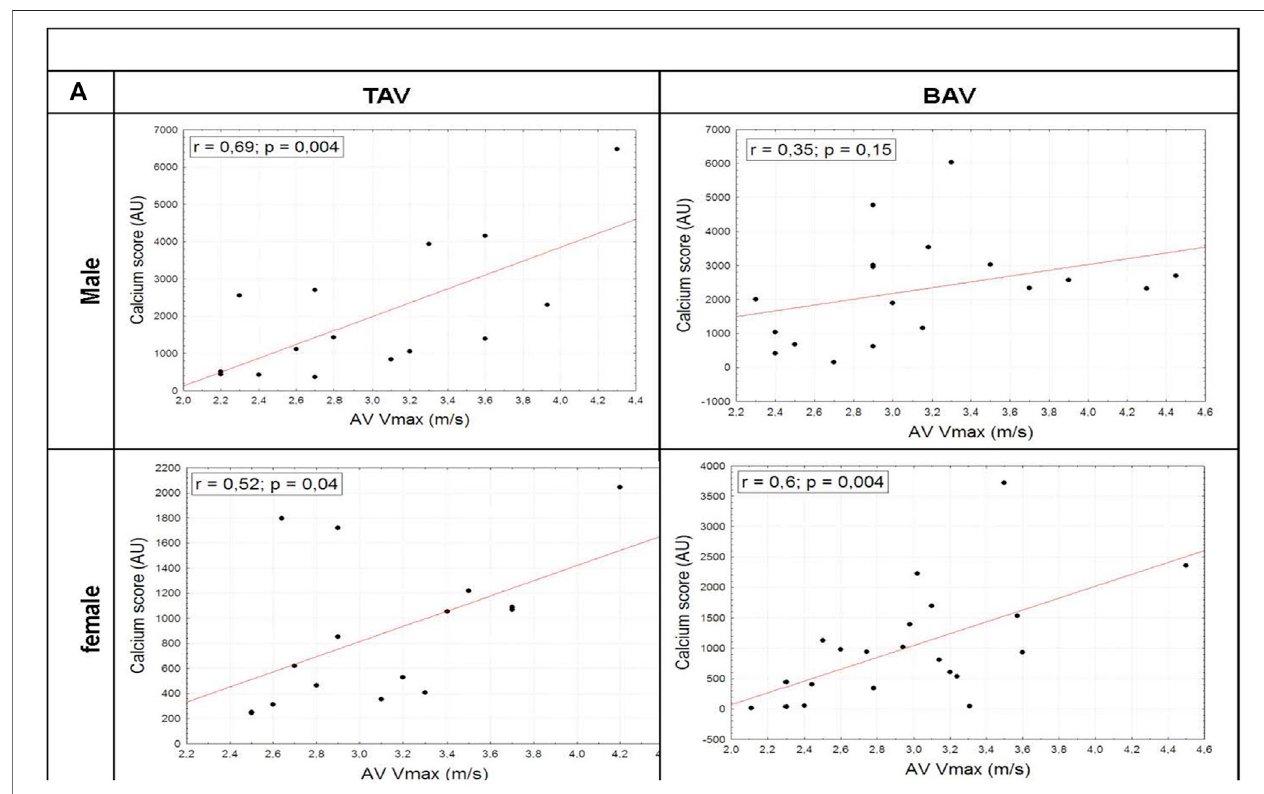
FIGURE 2 | Correlations between Vmax and Agatston score (A) , V max and 18 F-NaF TBR max, 18 F-NaF TBR mean, 18 F-NaF TBR max/mean in BAV and TAV groups (B) .